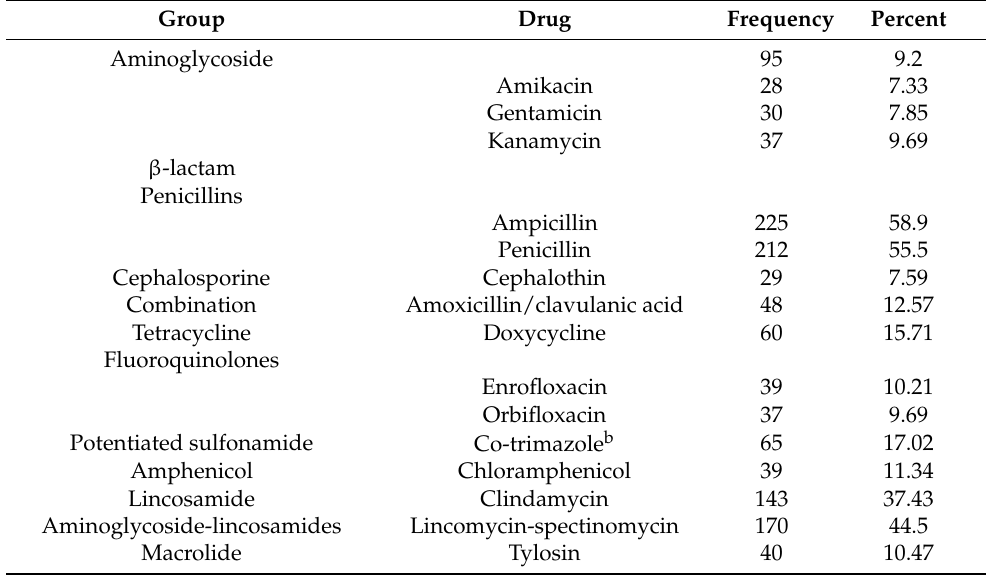
Table 1. Distribution of nonsusceptibility against 15 antimicrobials among 382 Staphylococcus species isolated at a veterinary academic hospital in South